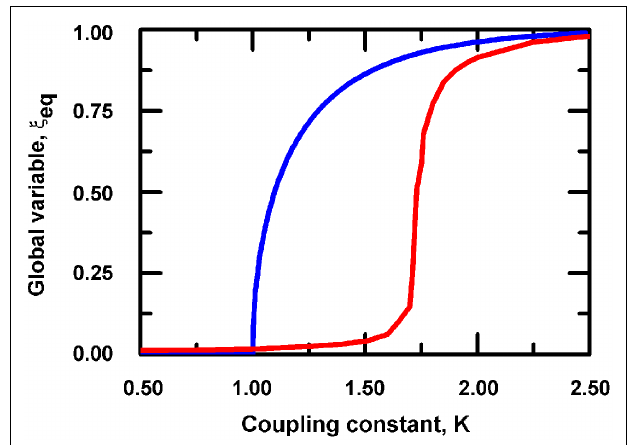
FIGURE 1 |The phase diagram for global variable ξ eq . Solid blue line corresponds to the equilibrium states obtained in the case of fully connected, infinite network N =∞ . Red line corresponds to the global states observed for two-dimensional regular lattice ( N = 100 × 100) and setting g =